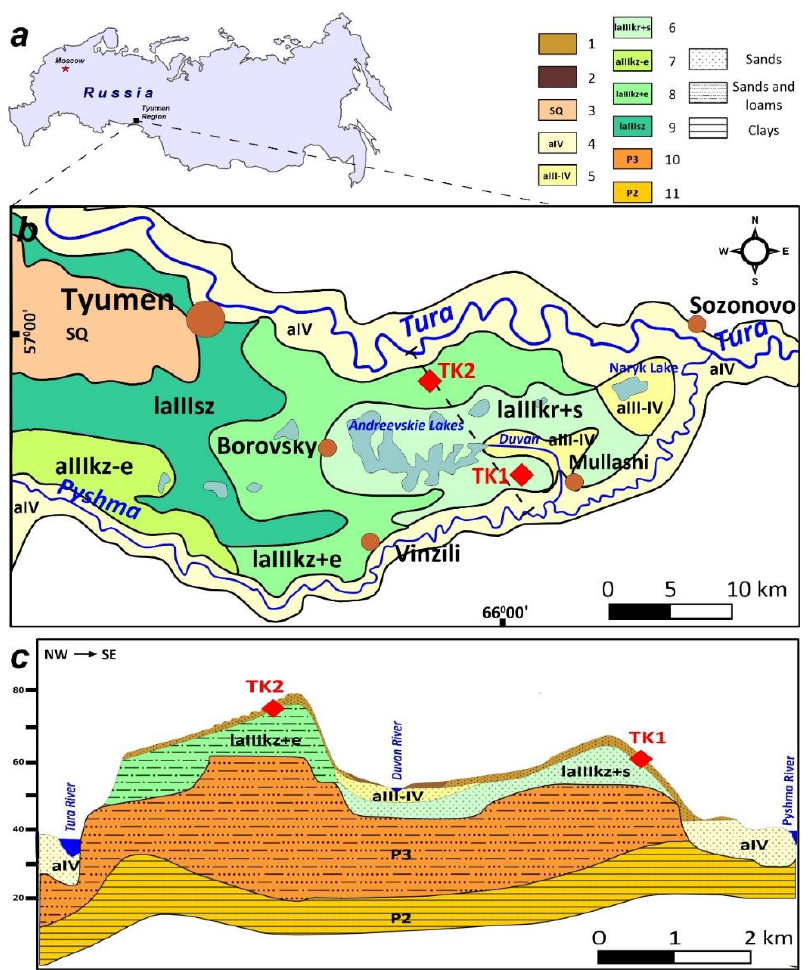
Figure 1. Location of the study sites: ( a ) within the territory of Russia; ( b ) on the simplified map of quaternary deposits of the Tura–Pyshma interfluve according to [70]; ( c ) a simplified cross section between TK1 and TK2 sites according to [67,70] with some modifications, where: 1—covering aeolian sands, 2—Holocene peat deposits; 3—poorly defined covering loess-like loamy deposits; 4—modern alluvial deposits of floodplains (aIV); 5—alluvial deposits of the first floodplain terrace (aIII-IV); 6—Late Pleistocene lacustrine and alluvial deposits of the Karginsky and Sartan horizons (laIIIkr + s); 7—Late Pleistocene alluvial deposits of the third floodplain terrace, Kazantsevky and Ermakovsky horizons (aIIIkz-e); 8—Late Pleistocene lacustrine and alluvial deposits of the Kazantsevky and Ermakovsky horizons (aIIIkz + e); 9—Middle Pleistocene lacustrine and alluvial deposits of the Suzgunskaja sequence (laIIsz); 10—Oligocene deposits of the Turtass and Kurtamysh formations (P3); 11—Eocene deposits of the Tavda formation (P2).